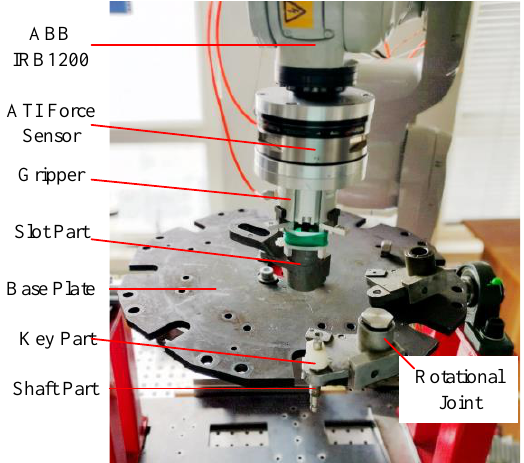
Figure 12. The experiment platform of irregular peg-in-hole with partial constraint.